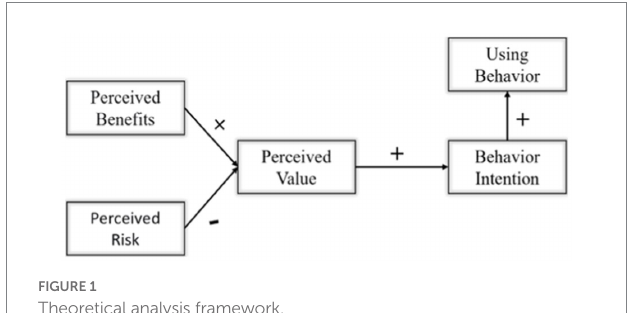
FIGURE 1 Theoretical analysis